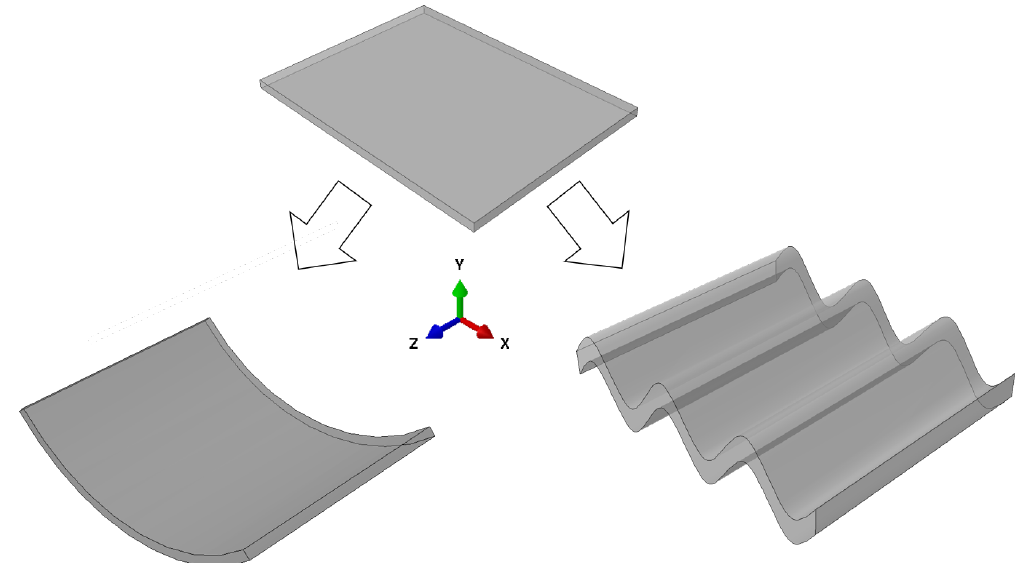
Figure 4. A plate-like structure has a much lower bending stiffness around the x -axis than a shell-like structure ( left ) or corrugated sheet structure ( right ) with the same